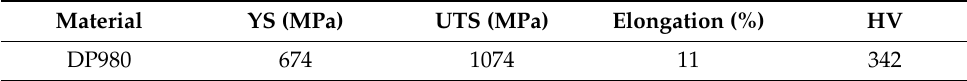
Table 2. Uniaxial tensile properties and hardness of DP980